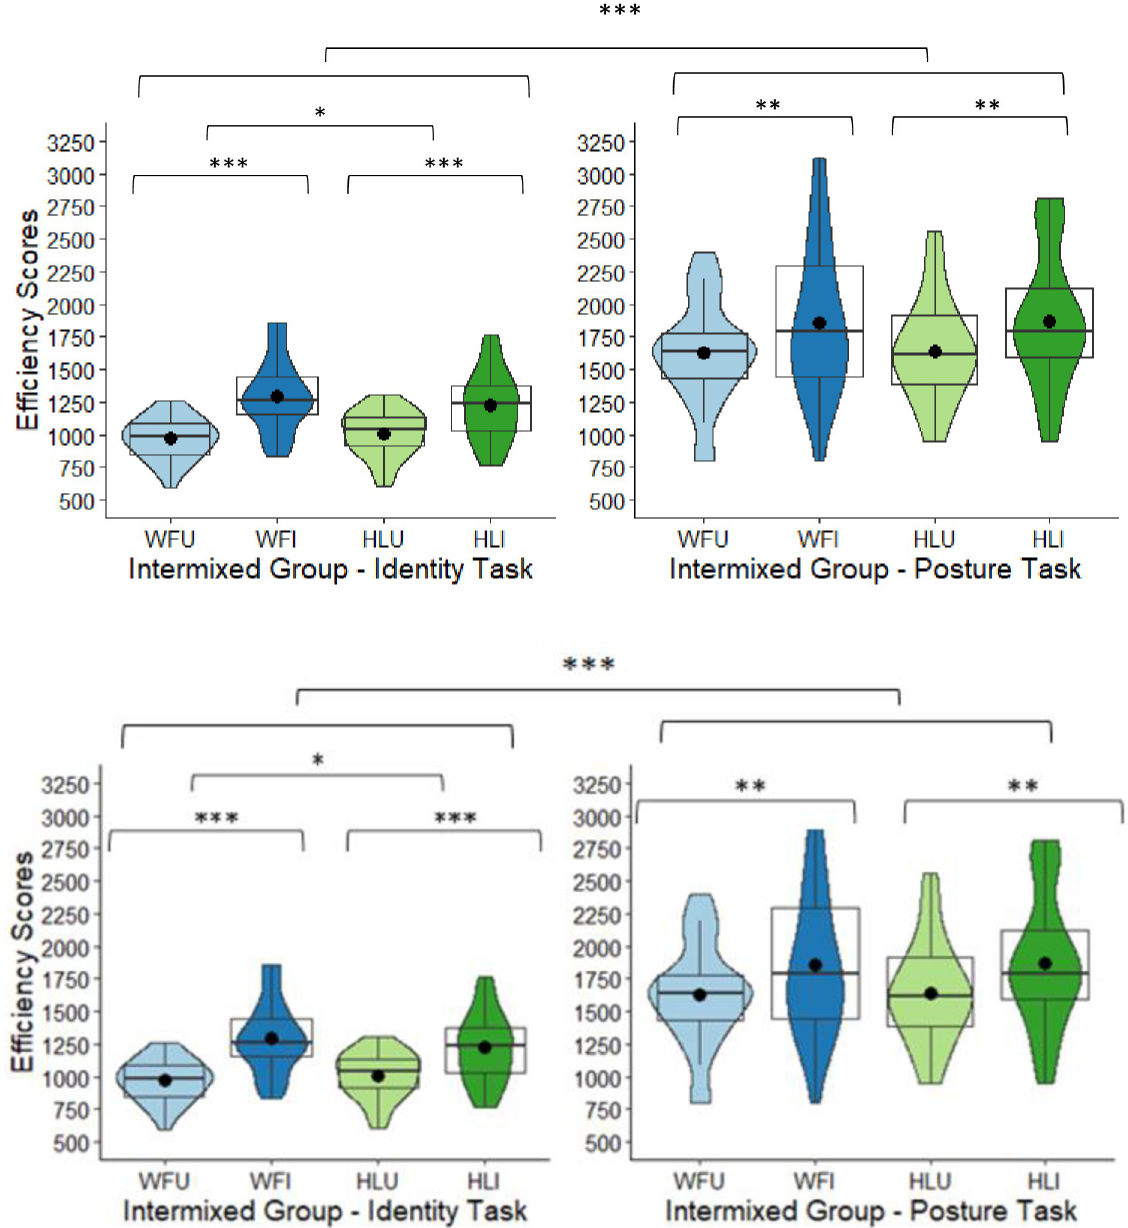
Fig 4. Intermixed group’s box and violin plots of efficiency scores for the four conditions: Whole figure upright (WFU), whole figure inverted (WFI), headless upright (HLU), headless inverted (HLI) in the identity task and posture task; dots denote means; ��� = p < .001; �� = p < .01; � = p <